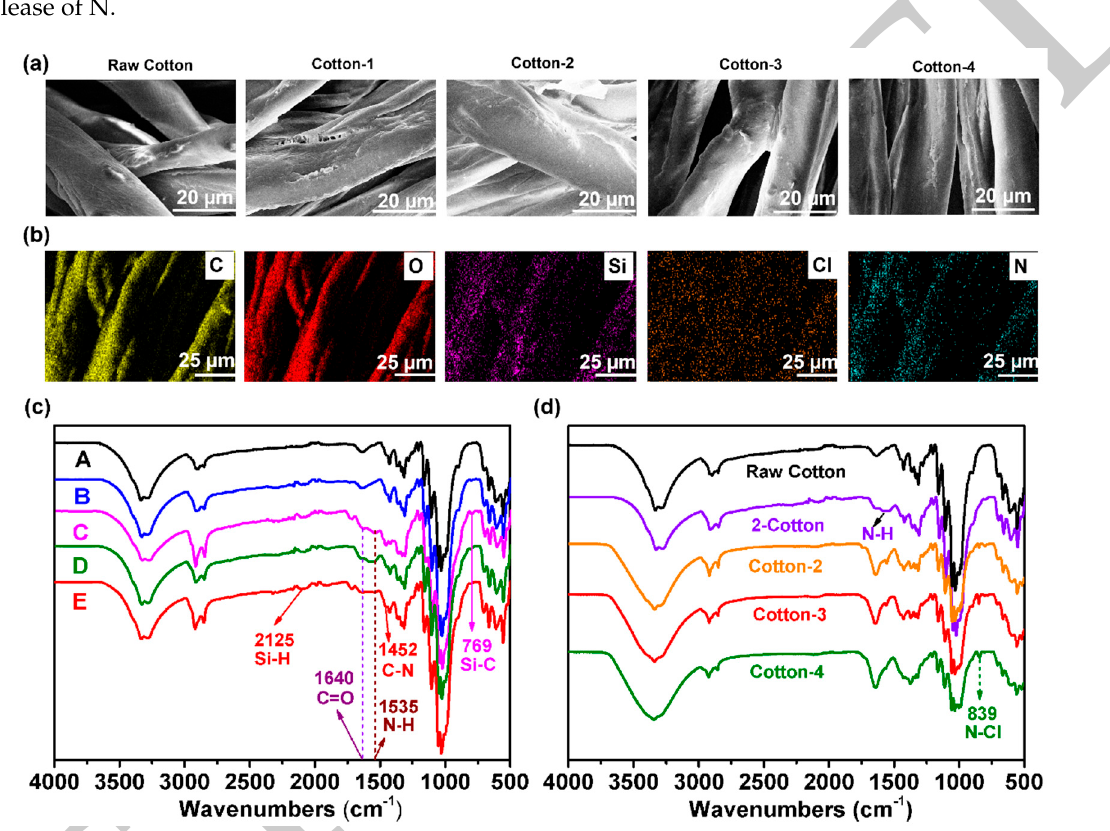
Figure 3. ( a ) The SEM photograph of cotton fabric samples. ( b ) Mapping results of the elements